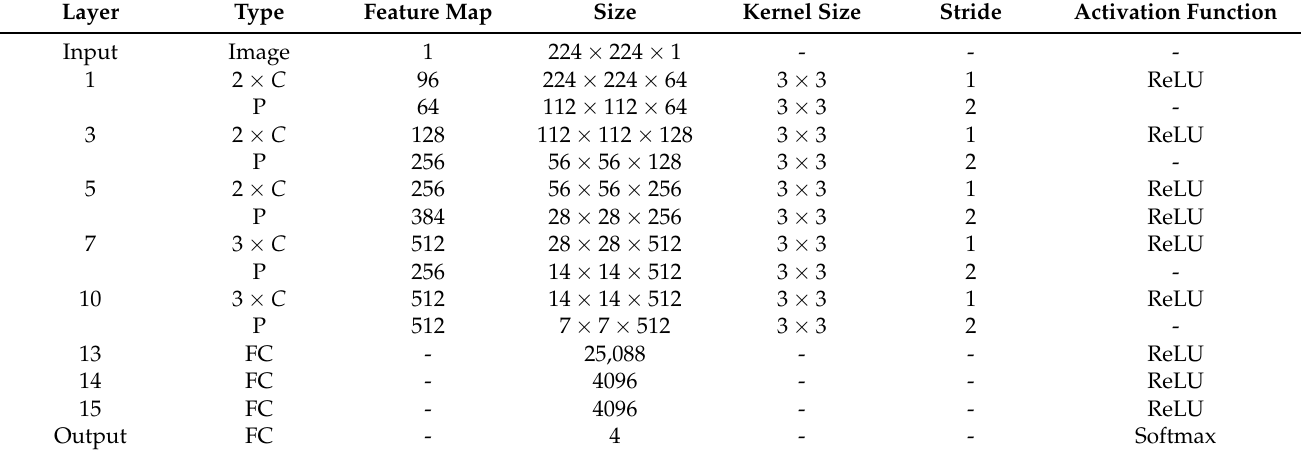
Table 2. Description of VGG 16 architecture (C—convolutional layer; P—Max pooling; FC—fully connected).